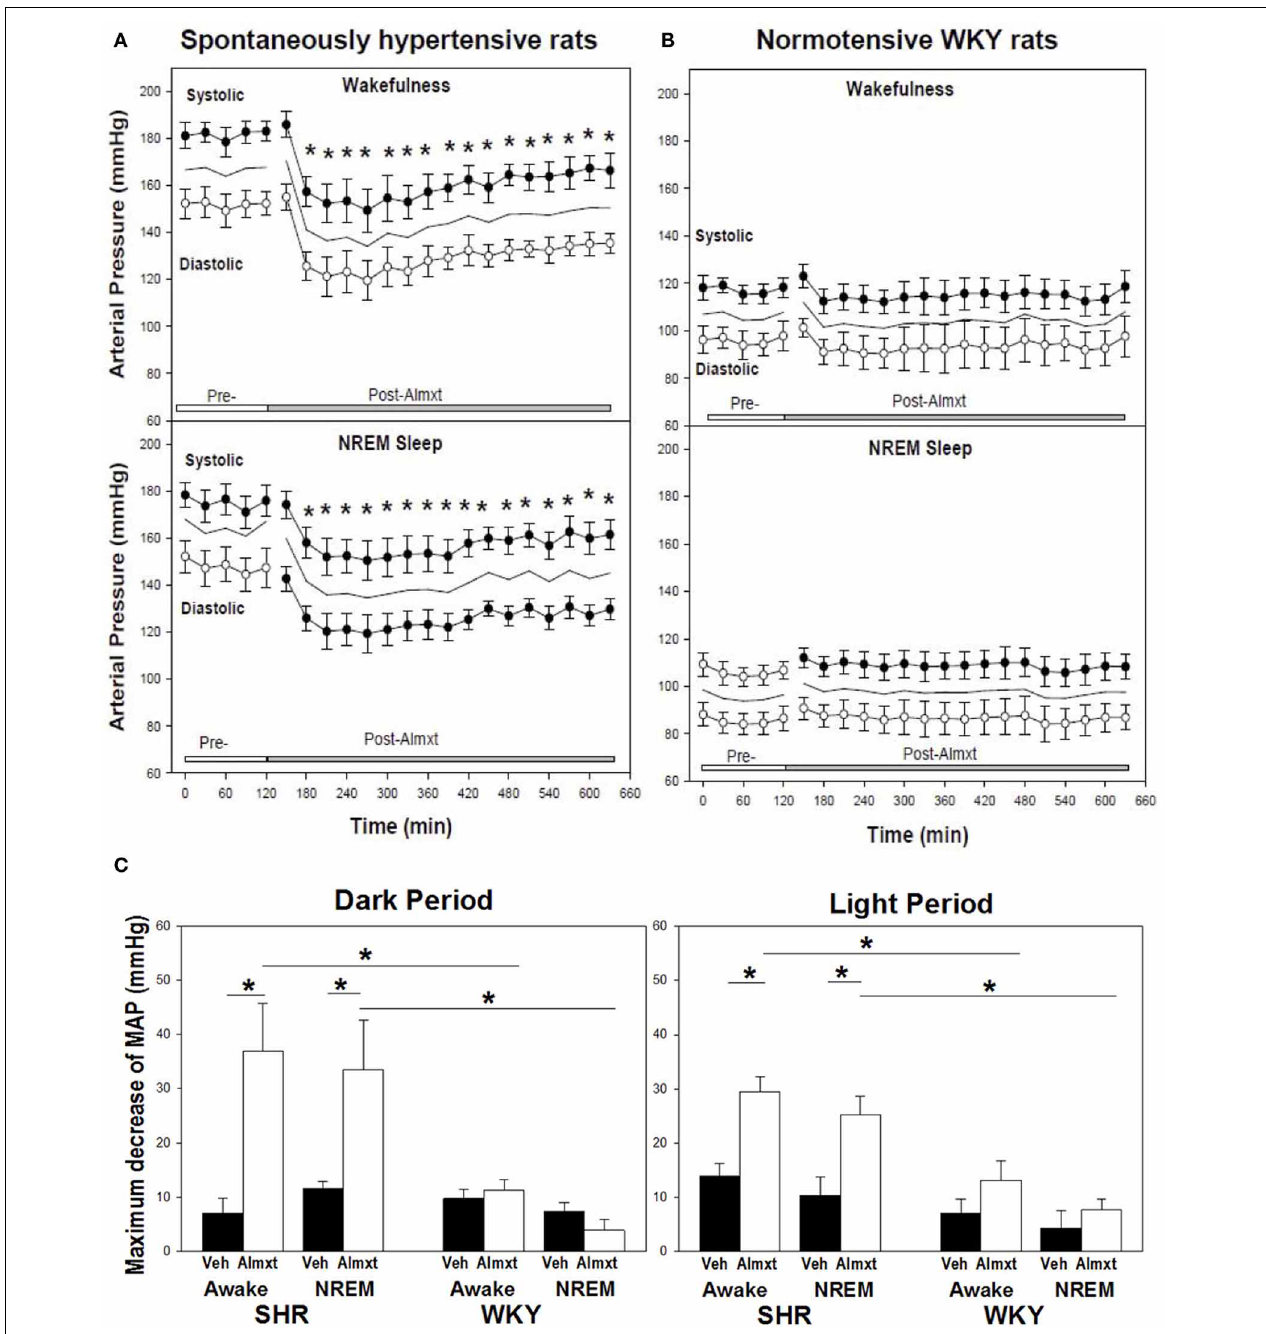
FIGURE 6 | In SHR, antagonism of OXRs with a systemic OXR antagonist, Almxt, decreases arterial pressure. One does of orally administered amlxt significantly decreased arterial pressure in SHR for ∼ 8h (A) , and Almxt had no effect on arterial pressure in normotensive WKY rats